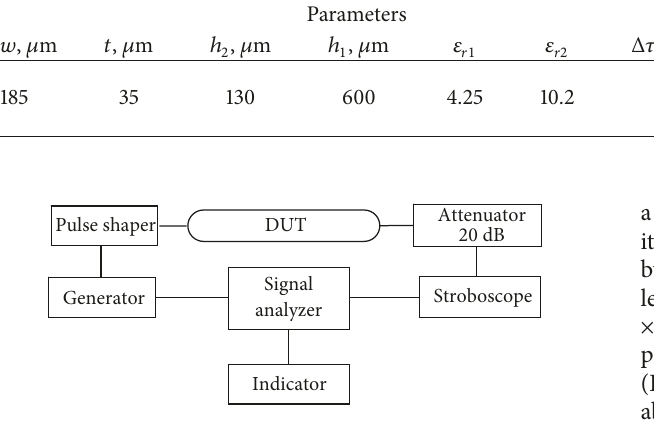
Figure 4: Schematic diagram of the experimental setup.